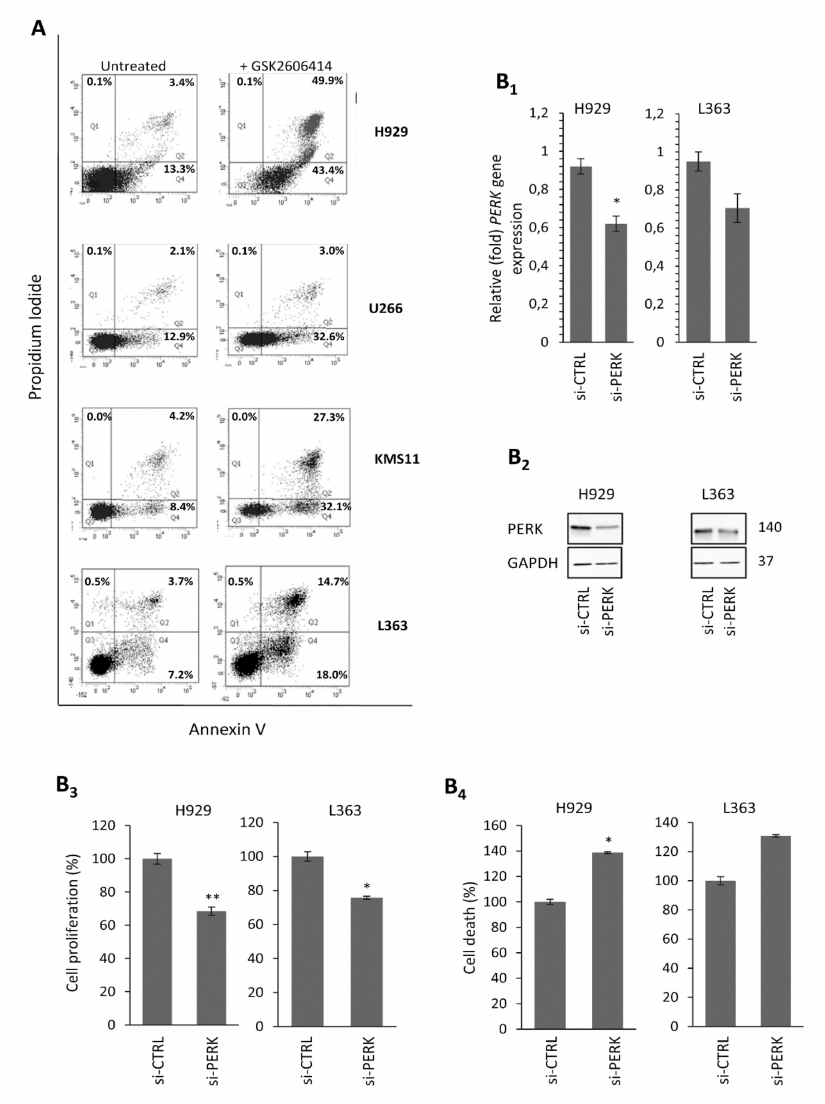
Figure 3. ( A ) Annexin V–propidium iodide (PI) staining of MM cell lines exposed to GSK2606414 for 48 h; to setup compensation and quadrants, unstained cells, cells stained only with Annexin V and cells stained only with PI were used as controls. Representative dot plots are shown out of two experiments performed. ( B 1 ) Q-PCR assay of PERK mRNA expression levels after transfecting H929 and L363 cell lines with PERK RNAi oligonucleotides or a non-targeting pool (si-CTRL) for 72 h. ( B 2 ) Immunoblotting analysis of PERK protein expression levels after transfecting H929 and L363 cell